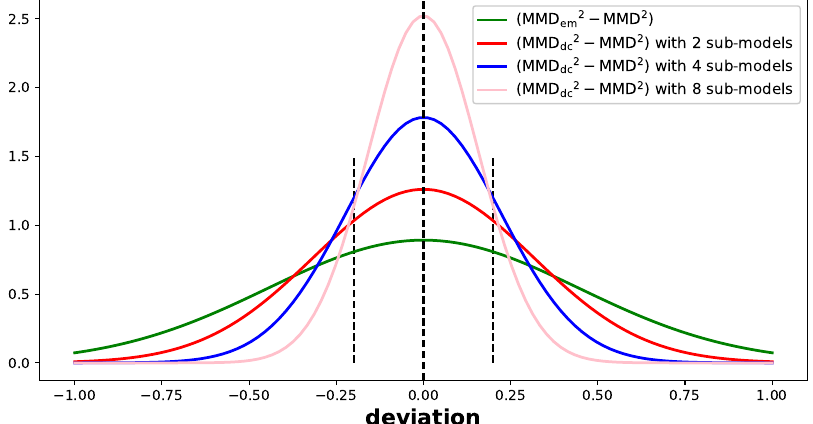
Figure 3. The distribution of deviation between the square of empirical estimate and MMD 2 . Besides the original model, we set the number of sub-models of DC-MMD-GANs to 2, 4, and 8. The distribution of deviation of original MMD-GANs (green curve) have high variance, which means that the loss function of MMD-GANs has loose deviation bound. The loss function of DC-MMD-GANs has relatively tight deviation bound and the bound becomes tighter as the number of sub-models